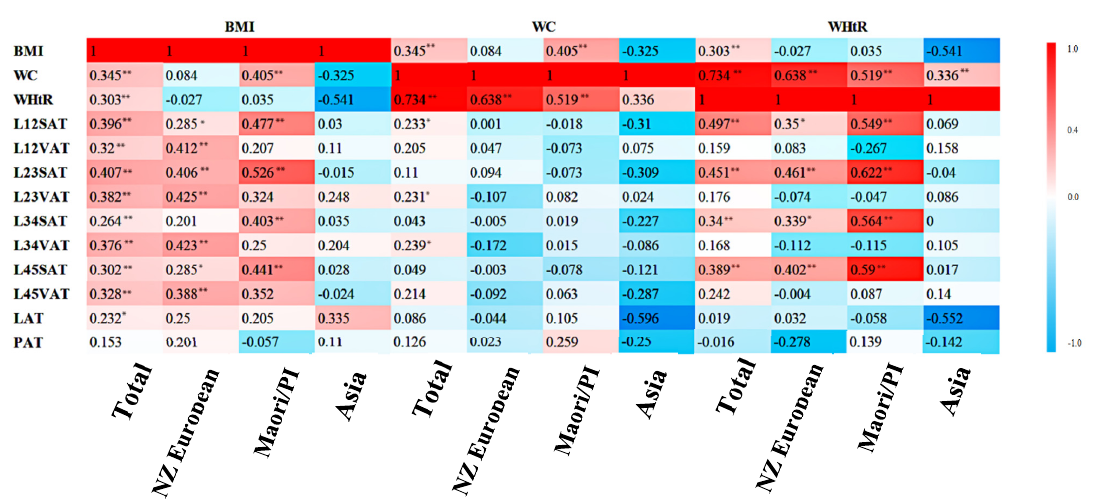
Figure 2. Pearson’s r values are presented, significant difference value is p ; * and ** indicate significance at the 95% and 99% level, respectively.